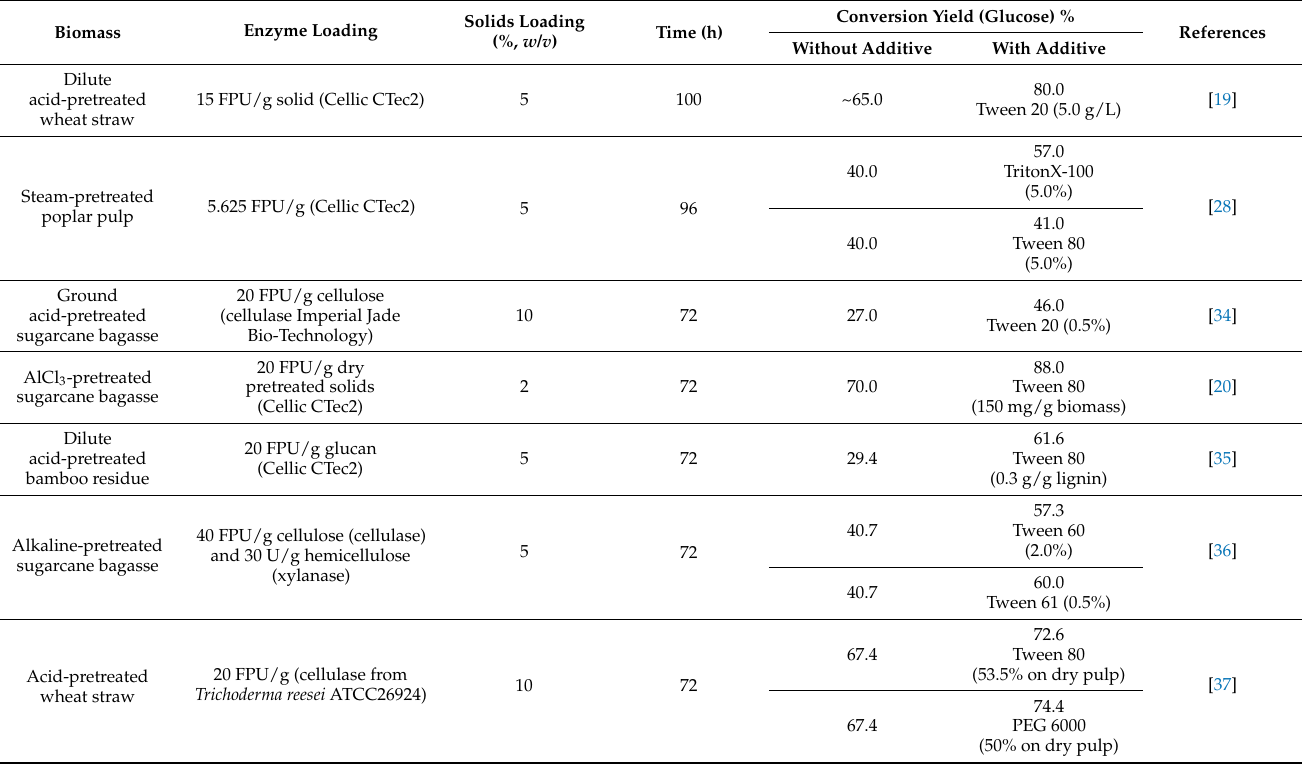
Table 1. Effect of several surfactants on the glucan conversion yield of enzymatic hydrolysis of lignocellulosic